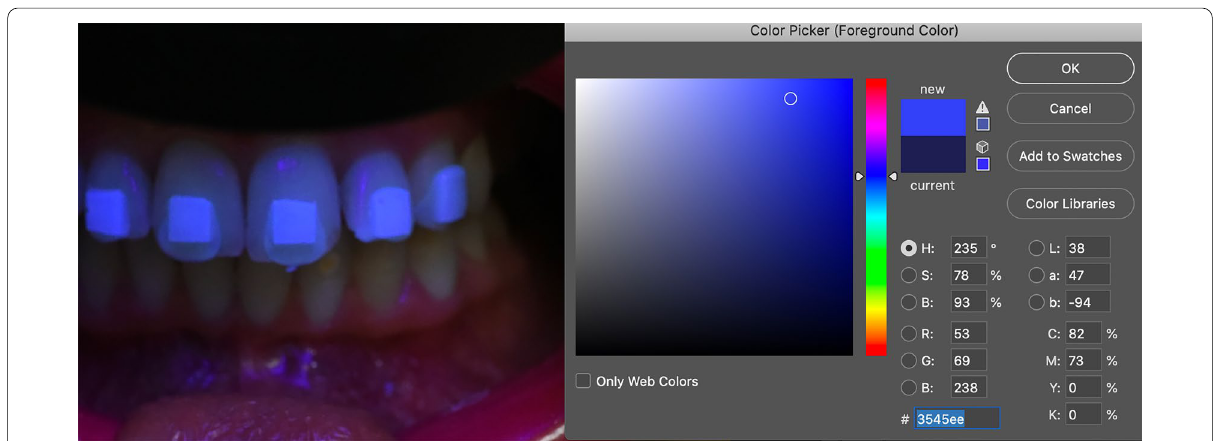
Fig. 3 The “color picker” tool of the software to analyze the brightness differences between areas with and without